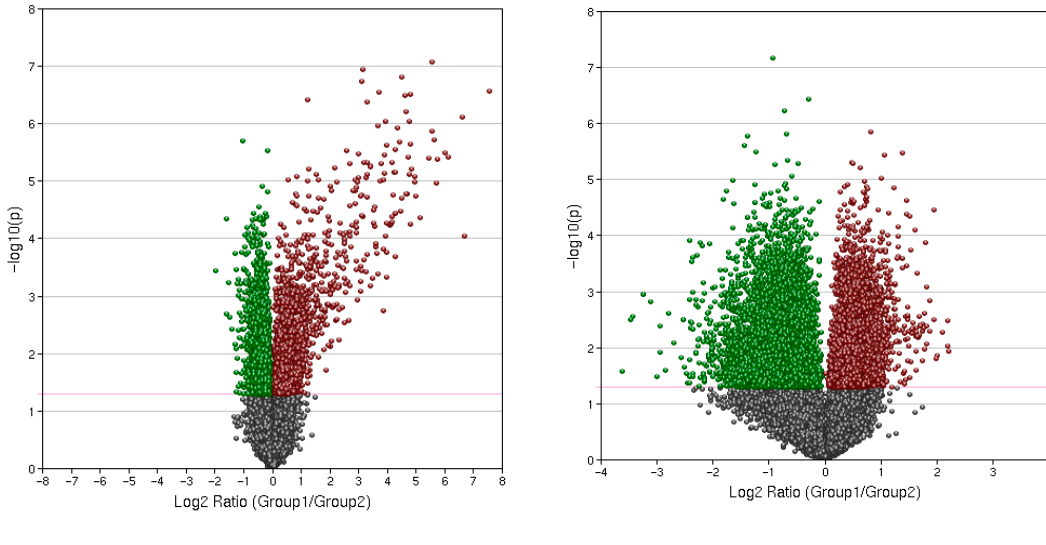
Figure 5. A volcano plot showing relationship between fold-change of gene expression (CSC; SCSC) and statistical significance. The x -axis displays magnitude of fold-change on a log scale and y -axis displays statistical significance − log10 of p value. The magenta line shows p = 0.05 cut-off, with points above the line falling in p < 0.05 region and below the line in p > 0.05 region. The red data points indicate upregulation and the green indicate down regulation. The points having a fold-change less than 2 (log2 = 1) are shown in gray.